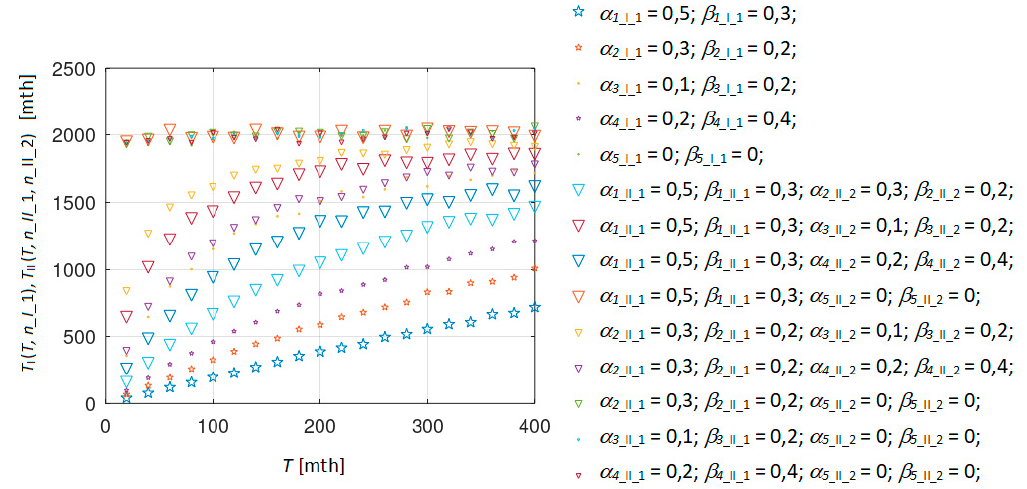
Figure 6. The expected number of system failures for the inspection interval T if the one-stage and various combinations of the two-stage policies are applied.